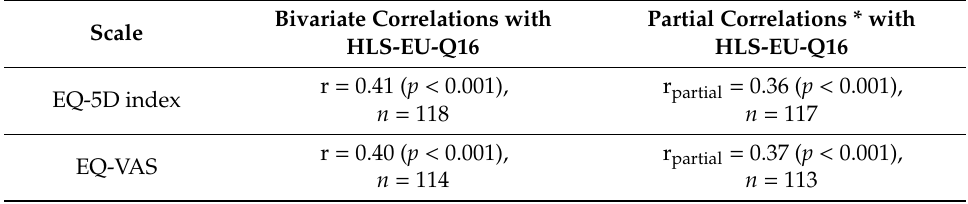
Partial Correlations * with HLS-EU-Q16 r partial = 0.36 ( p < 0.001), n = 117 r partial = 0.37 ( p < 0.001), n =